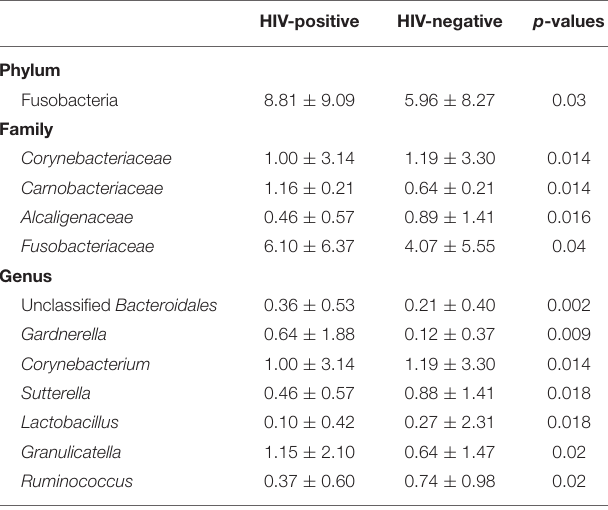
TABLE 3 | Average relative abundance of rectal microbial communities showing significant differences between HIV-positive and negative subjects.